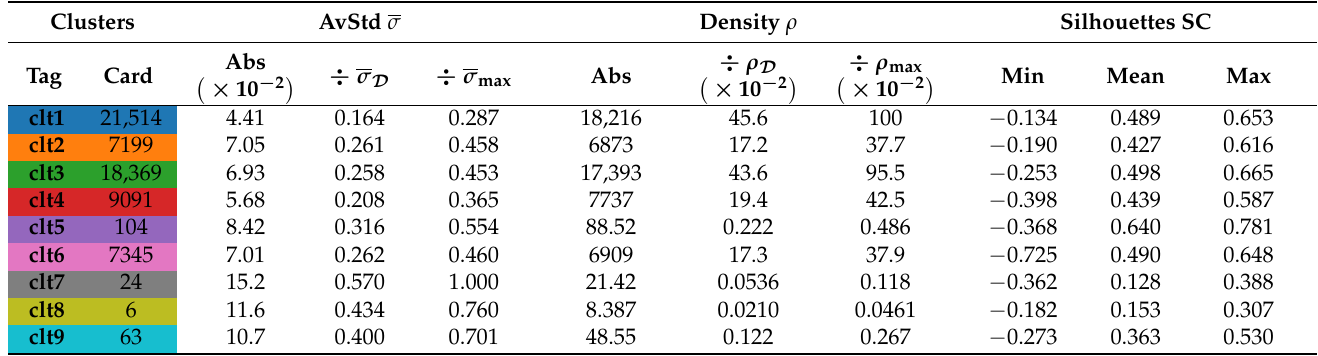
Table 7. Battery 2 quantification of the clustering: AvStd, density, and SCs. “Abs” is the absolute value of the quantifier γ , whilst “ ÷ γ D ” is this value divided by that of the database, and “ ÷ γ max ” by its maximum. “Min”, “Mean”, and “Max” are the minimum, mean, and maximum of the silhouettes. See Table 3 for the details about the color